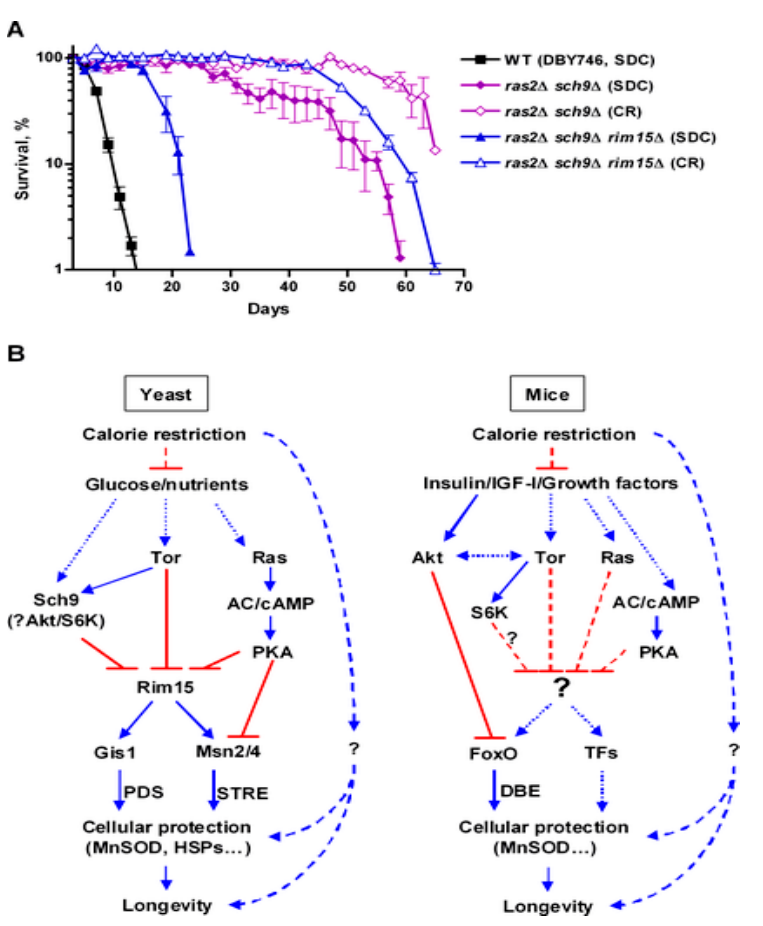
Figure 1. Relative contribution of genetic and nutrient manipulation on yeast lifespan. ( A ) CR cultures were switched to water-only at day 3 mimicking fasting condition. ( B ): Side by side comparison of yeast and mammalian aging pathways. Reproduced from [33].